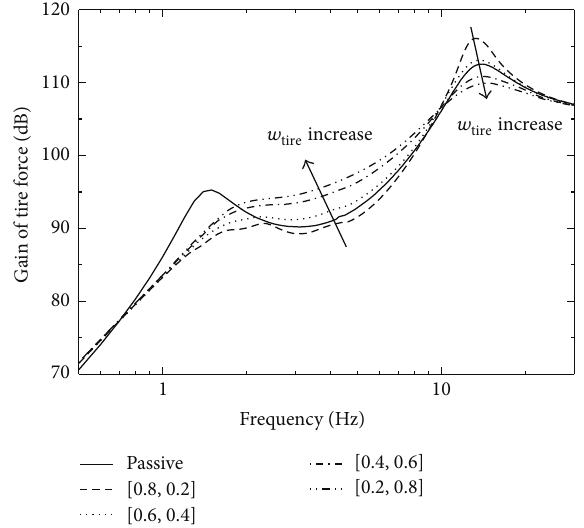
Figure 10: Comparison of frequency responses of 𝑓 𝐷 /𝑥 𝑟 for differ- ent control